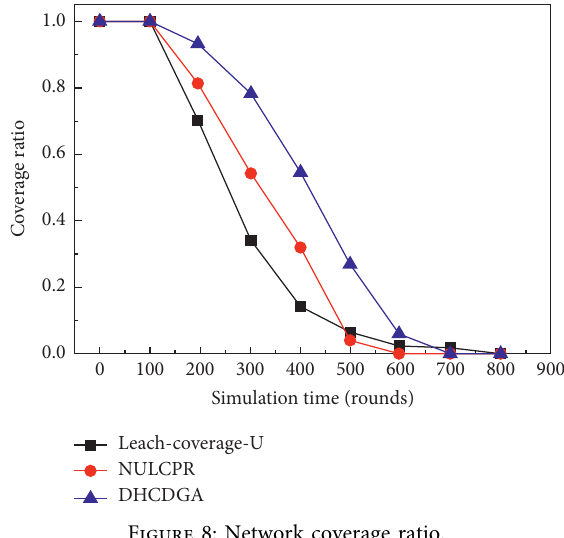
Figure 8: Network coverage